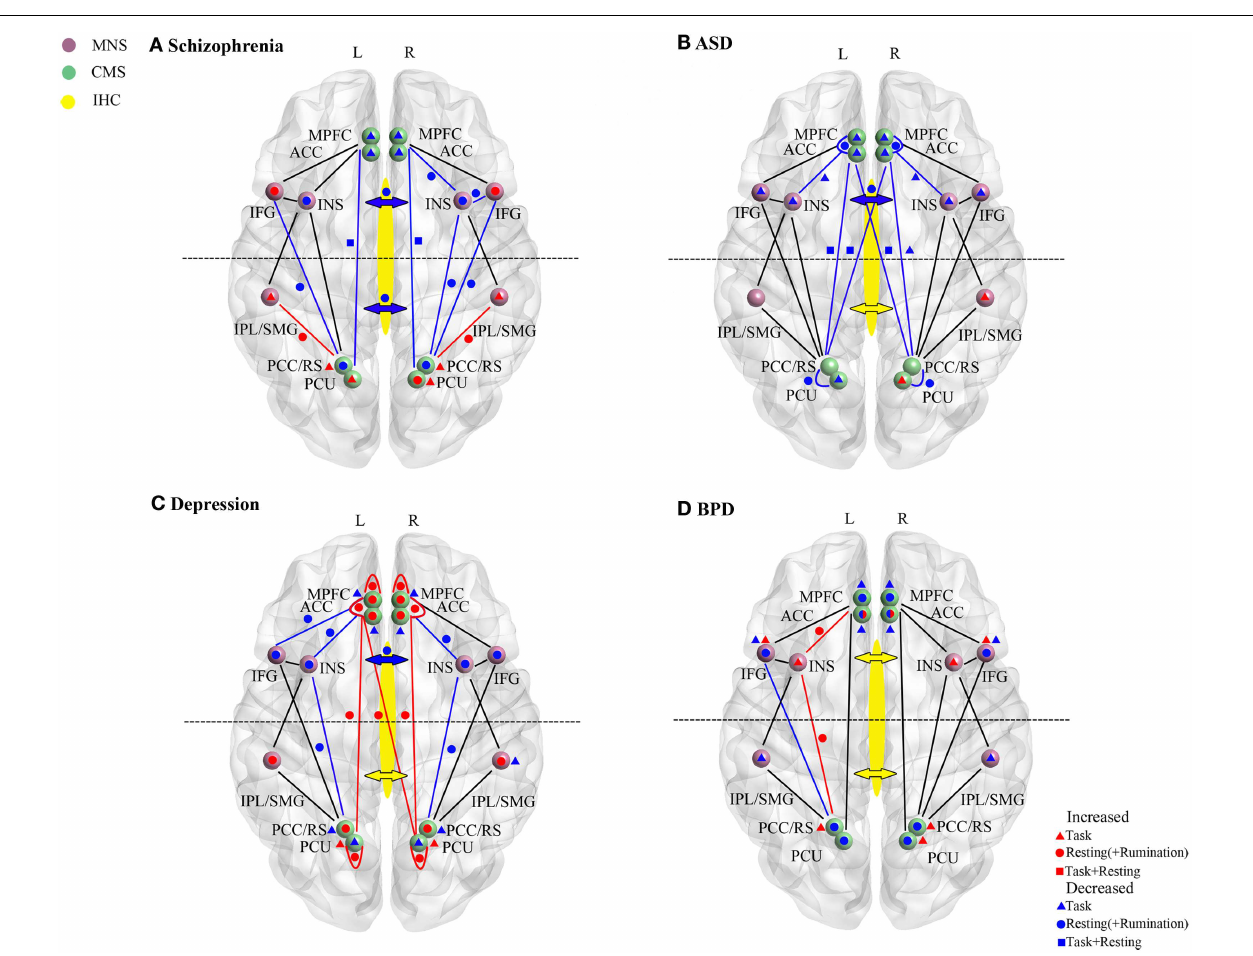
autobiographical information). For simplicity even where multiple studies in the text report the same direction of change in their findings only a single symbol is used. In the CMS increases or decreases are delineated in terms of the difference in the magnitude of the signal change compared to control subjects rather than the direction of change. For depression resting-state and rumination-induction studies are combined for simplicity since they always show changes in the same direction. Changes in frontal or middle/posterior functional connectivity via the corpus callosum and indicated by the anterior or posterior arrows (red, increase; blue, decrease). In some cases for BPD contradictory findings are indicated either within resting-state or task-dependent studies (i.e., for the AC and IFG). For abbreviations see Figure 1